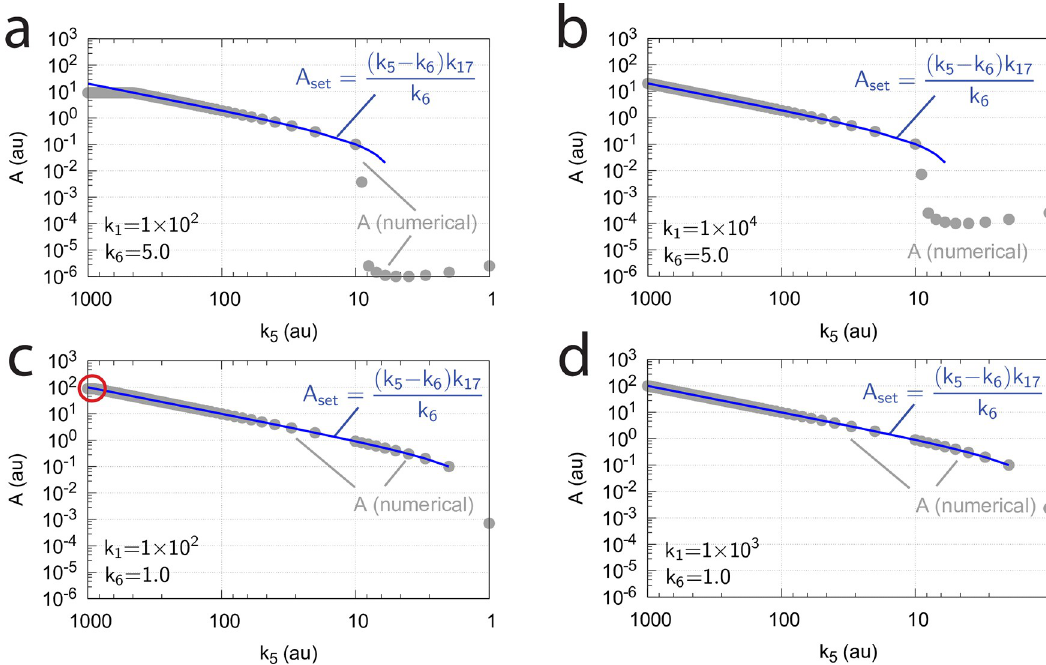
Fig 61. Influence of k 1 on the homeostatic behavior of the m7 ping-pong controller when E 1 binds first to free enzyme Ez . Since the response of the controller at higher k 1 values becomes significantly slower the numerical A values are calculated after 10 6 time units and compared with positive A (blue lines) as a function of k 5 . (a) k 1 =100.0, k 6 =5.0. The controller looses homeostatic control set in the k 5 range from 460–1000. (b) Increasing k 1 from 100.0 to 10000.0 moves A ss to A set for the higher k 5 values, but not for the lower k 5 values. (c) A decrease of k 6 from 5.0 to 1.0 while k 1 is kept at 100.0 gives a general improvement of the homeostatic performance of the ping-pong controller, except for the higher end k 5 range between 900–1000, where A ss becomes constant values that match A . Other rate constants (a)-(d): (indicated by the red circle). (d) Low k 6 (1.0) and higher k 1 (1000.0) shows A ss set k 2 = k 3 =0, k 4 =10.0, k 7 =1 × 10 8 , k 9 = k 11 = k 13 =1 × 10 7 , k 12 = k 14 =1 × 10 3 , k 17 =0.1. Initial concentrations (a)-(d): A 0 =3.0, E 1,0 =1.0 × 10 − 2 , E 2,0 =3.0 × 10 2 , Ez 0 =1.0 × 10 − 6 , (E 1 � Ez) 0 = Ez � =(Ez � � E 2 ) 0 0